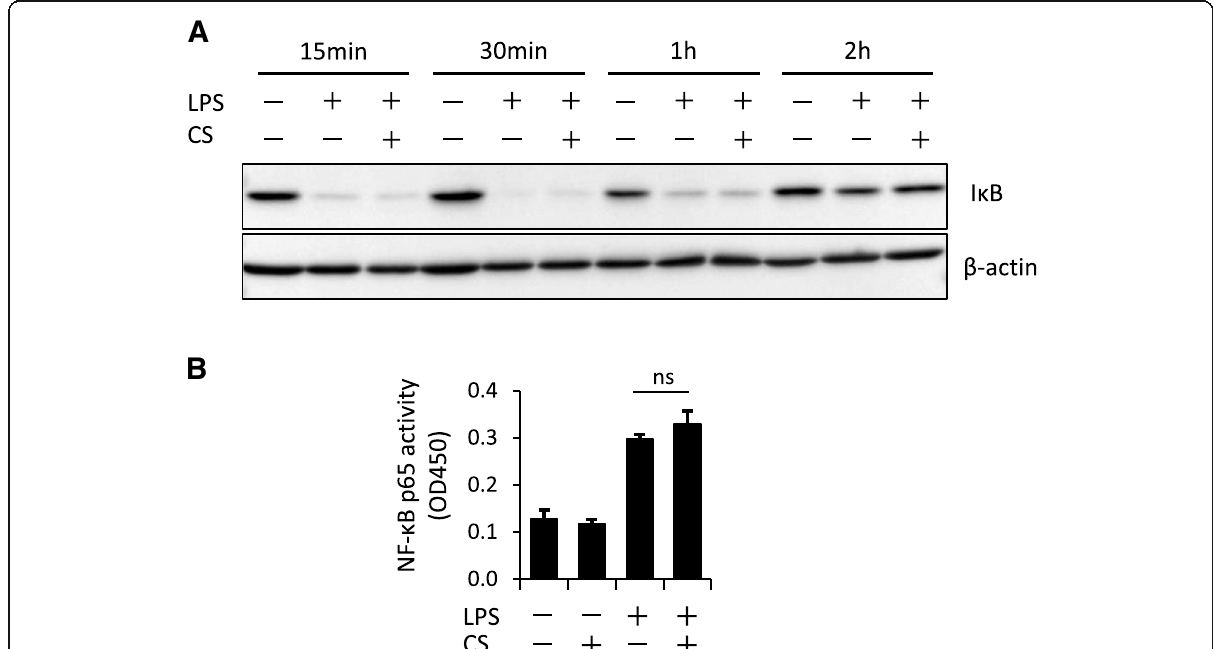
Fig. 4 Cyclic stretch does not alter the LPS-induced NF- κ B signaling pathway. a J774.1 cells were exposed to cyclic stretch of 20% elongation at a frequency of 10cycles/min with 100ng/mL LPS for the indicated times. Cell lysates were analyzed by western blotting with anti-I κ B- α . An antibody against β -actin was used as a control. b J774.1 cells were exposed to cyclic stretch of 20% elongation at a frequency of 10cycles/min for the first 2h during treatment with 100ng/mL LPS for 4h. Nuclear proteins were extracted from cells and an NF- κ B ELISA assay was performed. CS, cyclic stretch. ns, not